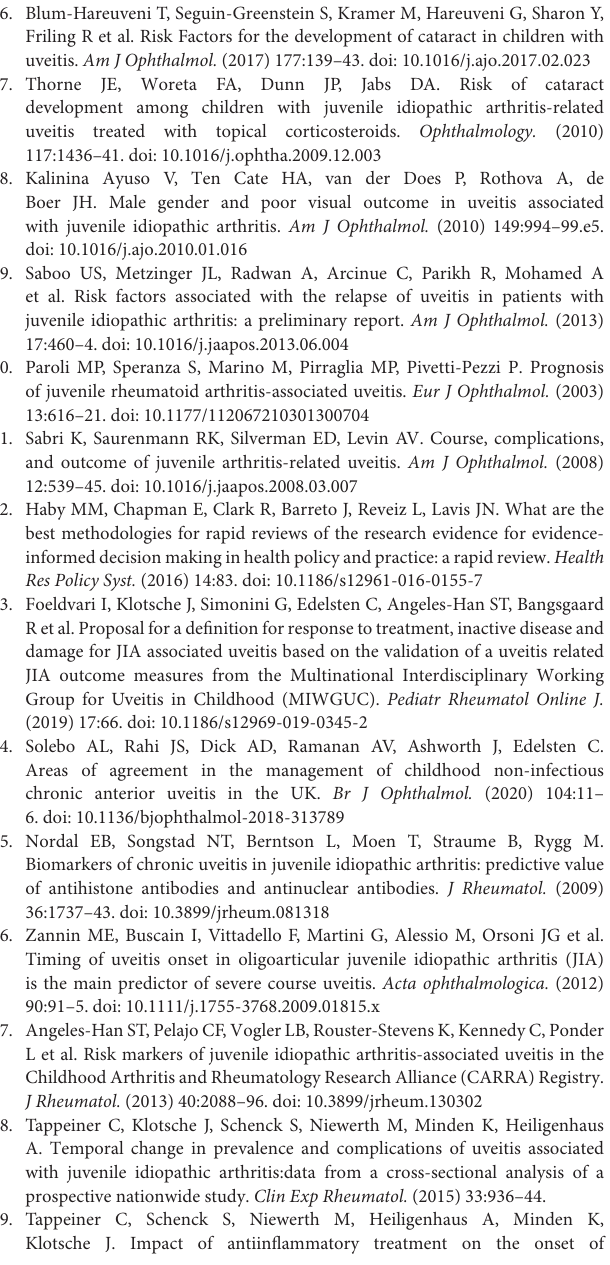
Supplementary Document 1 | List of studies used to inform the long-list in Phase 1. Supplementary Document 2 | List of cohorts, registries and core outcome sets used to inform the long-list in Phase 1. Supplementary Document 3 | Long list of candidate